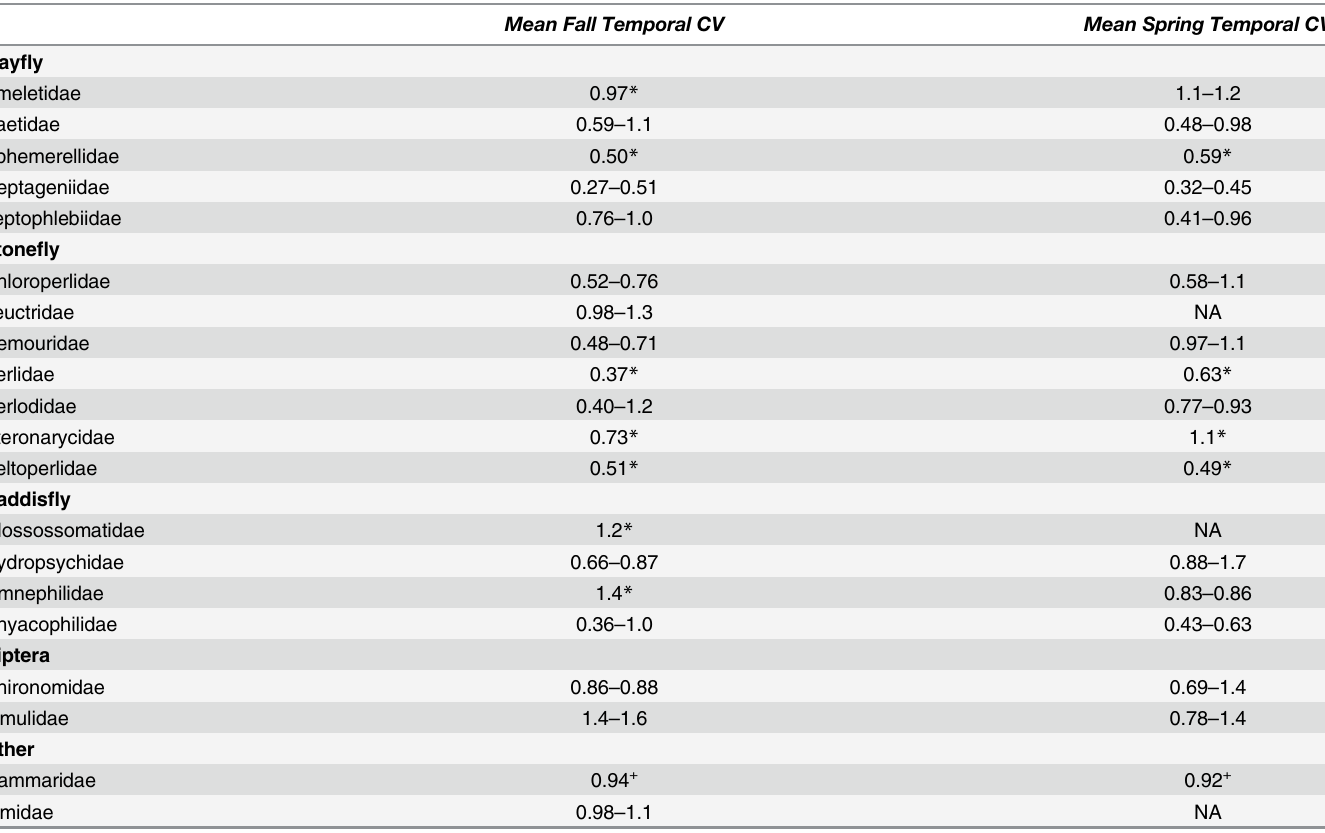
Table 3. CV for common families collected in Balch and Lookout Creeks from 2005 – 2015 for taxa present in at least 5 samples in each season. Some taxa were only present in either Balch Creek (+) or Lookout Creek ( * ).